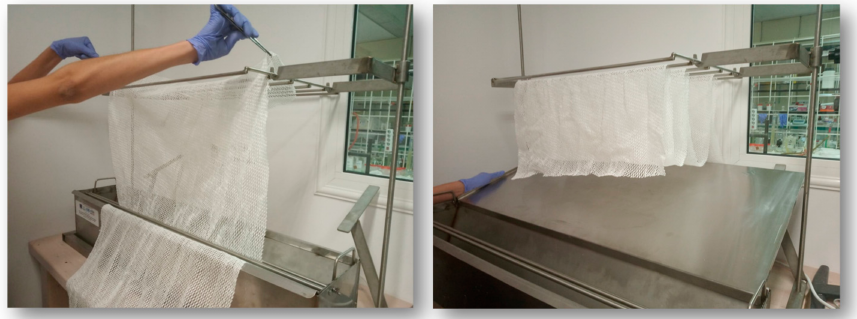
Figure 7. Homemade bath for nets’ coating with antimicrobial polymers on a pilot scale, equipped with a drying hang and a stainless-steel inclined